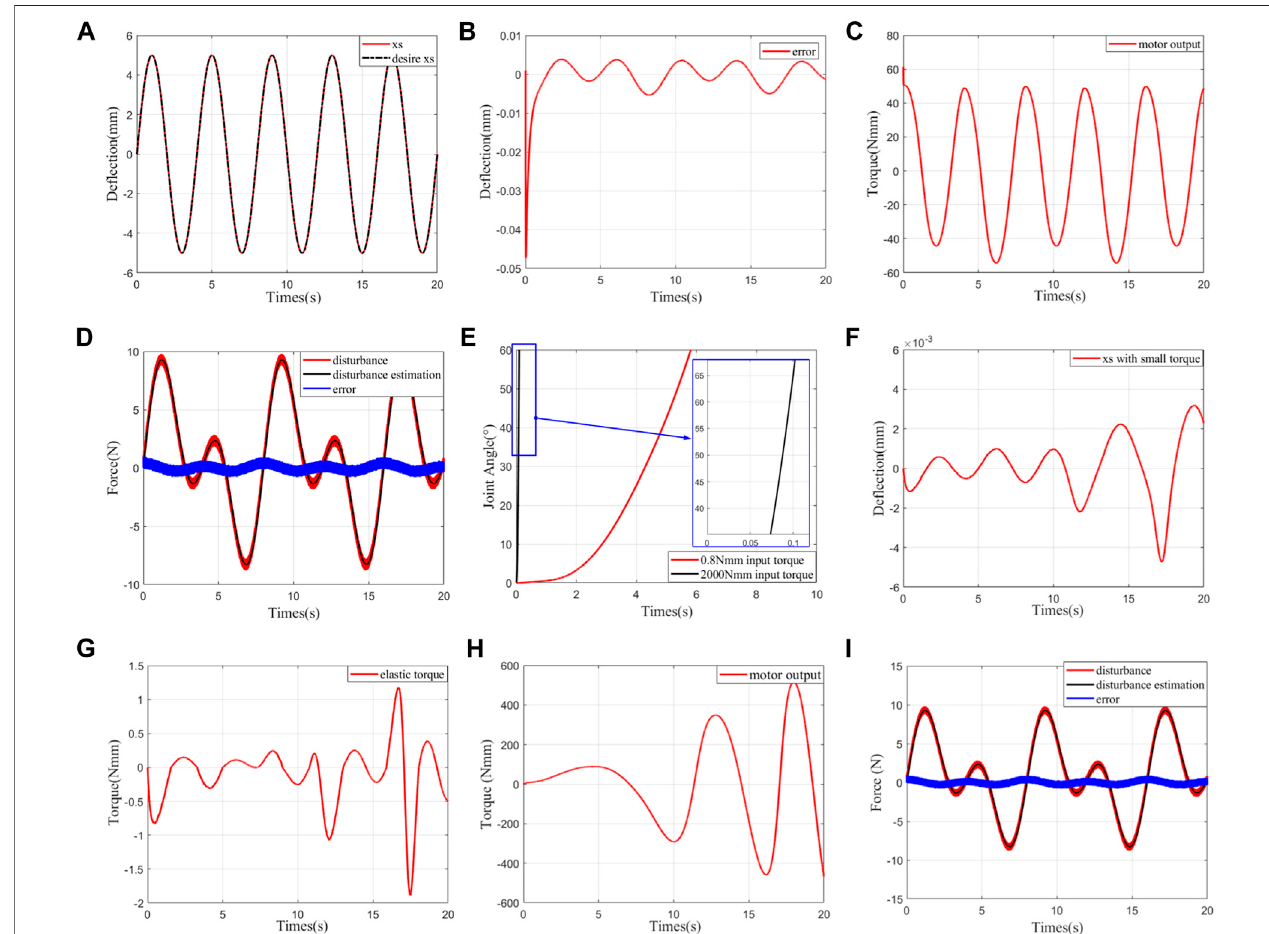
FIGURE5| Simulationresults. (A) Trajectorytrackingofde fl ectionat fi xedoutput. (B) Errorofde fl ectiontrajectorytrackingat fi xedoutput. (C) Motoroutput/control law at fi xed output. (D) Trajectory of disturbance observation at fi xed output. (E) Corresponding joint angles in zero-impedance control under different human – robot interaction torques. (F) De fl ection trajectory tracking at 0.8 Nmm human – robot interaction torque under zero-impedance control. (G) Elastic torque f ( x s ) r cos β applied to the joint/load side at 0.8 Nmm human – robot interaction torque under zero-impedance control. (H) Motor output/control law at 0.8 Nmm human – robot interaction torque under zero-impedance control. (I) Trajectory of disturbance observation at 0.8 Nmm human – robot interaction torque under zero-impedance control.